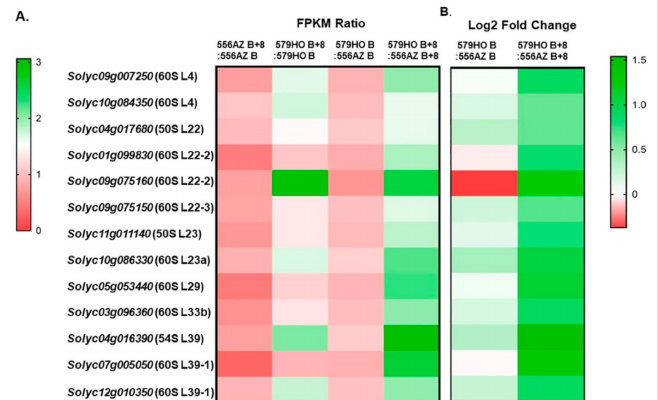
Figure 6. Heatmaps of gene expression analysis of the identified ribosome exit tunnel protein genes in the 556AZ and 579HO lines at breaker (B) and breaker + 8 (B + 8) stages. ( A ) FPKM expression ratios of 556AZ B + 8:556AZ B and 579HO B + 8:579HO B at B vs. B + 8 stages, and between 579HO B:556AZ B and 579HO B + 8:556AZ B + 8). ( B ) Di ff erential expression (log2 fold change) in 579HO as compared with 556AZ at B vs. B + 8 ripening stages. Heatmaps were performed using GraphPad Prism version 7.0 for Windows, GraphPad Software, La Jolla, CA, USA